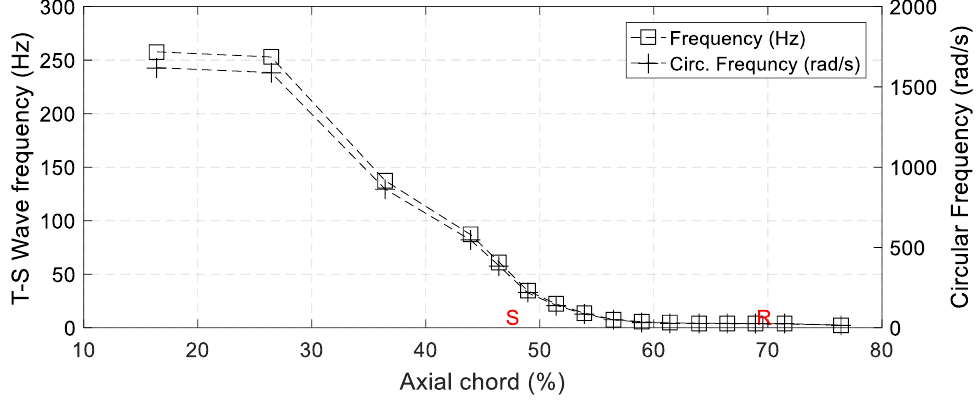
Figure 8. Most amplified T – S wave frequencies calculated using the correlation found in [9]. S and R represent the approximate locations of flow separation and reattachment from the current measurements.